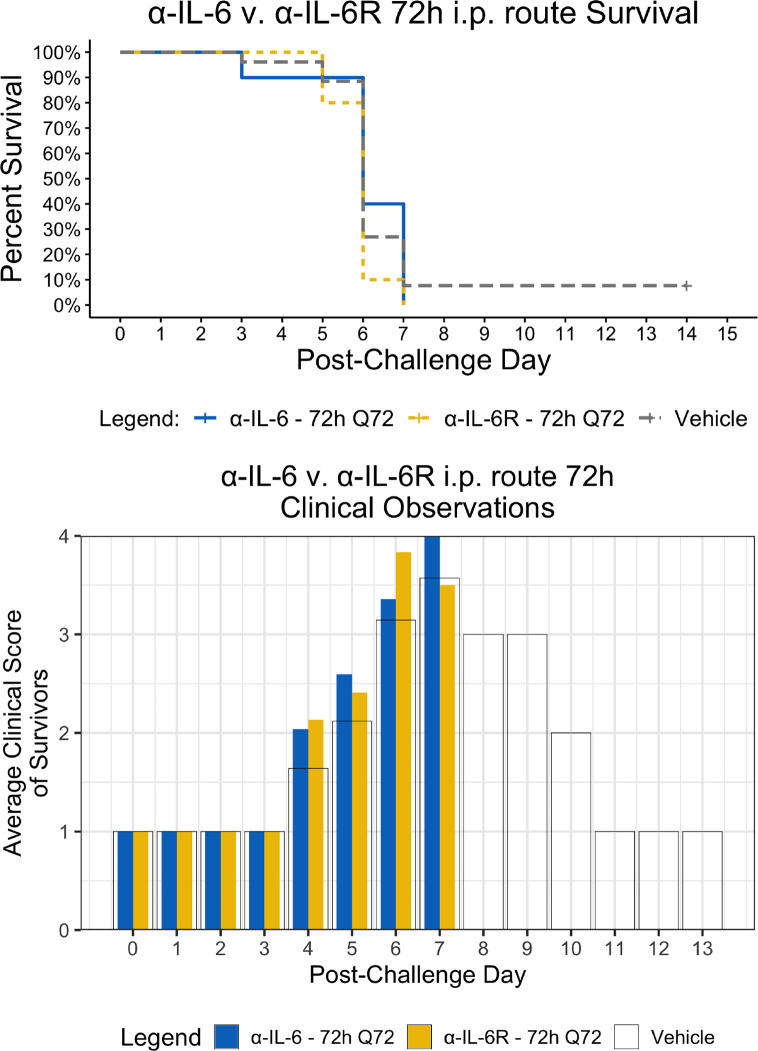
Kaplan-Meier Survival Plots and Average clinical scores for multiple i.p. doses of α-IL-6 or α-IL-6R administered 72 h after maEBOV challenge and followed by repeat dosing every 72 h for a total of four doses. The survival curves were significantly different by Log-rank (Mantel-Cox) testing (P < 0.05). SEM of the average clinical scores were < 10% of the mean.